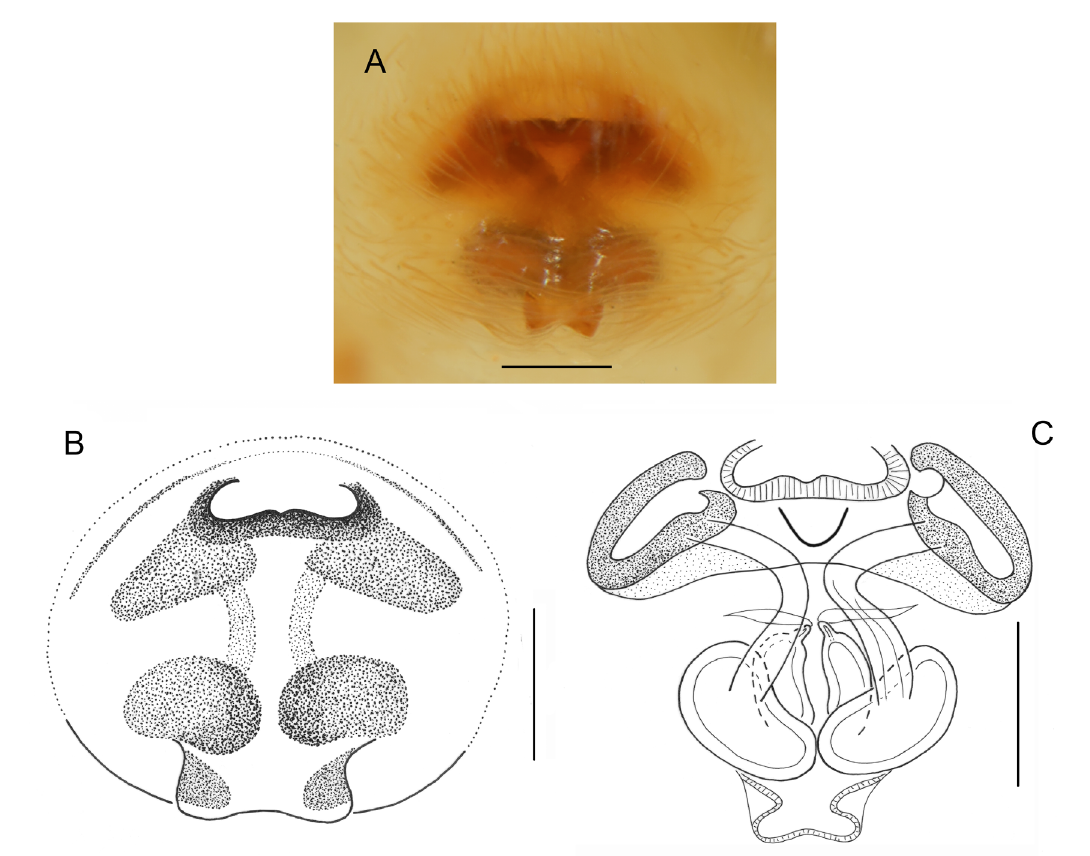
Fig. 4. Pochytoides monticola sp. nov., paratypes, ♀. A–B . Epigyne. C . Internal structure of epigyne. scale bars: 0.2